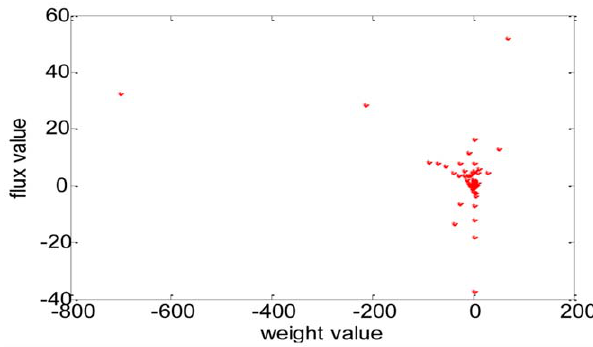
For E. coli , we have known all of its reactions, the values of corresponding D r G ’ m and the values of corresponding flux, so we and E out using the following equation (15) and can calculate its E ch in (16). Rin ~ X E ch in